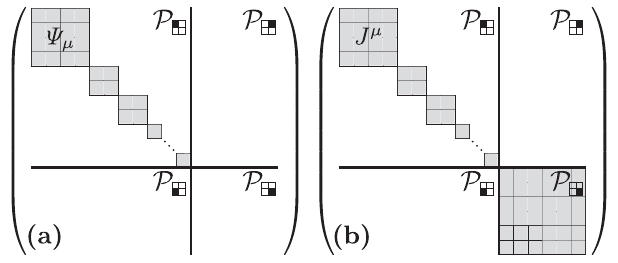
FIG. 1. Decompositions of the space of matrices Op ð H Þ acting on a Hilbert space H using the projections f P; Q g defined in Eq. (2.1) and their corresponding superoperator projections f P  ; P  ; P  ; P  g defined in Eq. (2.2). Panel (a) depicts the block diagonal structure of the asymptotic subspace As ð H Þ , which is located in  and spanned by steady-state basis elements Ψ H Þ , spanned by μ . Panel (b) depicts the subspace of Op ð conserved quantities J μ , that may leave a footprint on states in As ð H Þ in cases when there are multiple steady